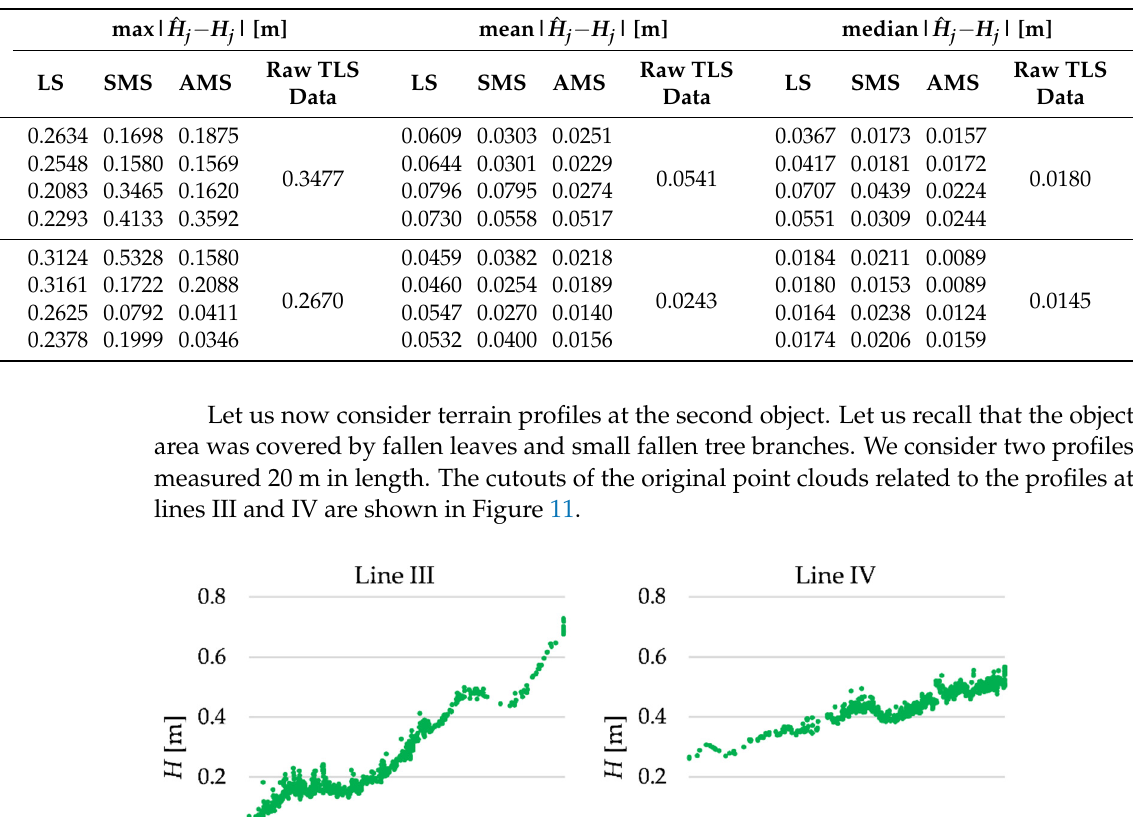
(cid:12) (cid:12) H H − for lines I and II. (cid:12) (cid:12) ˆ H − H j j j j (cid:12) (cid:12) for lines I and II.